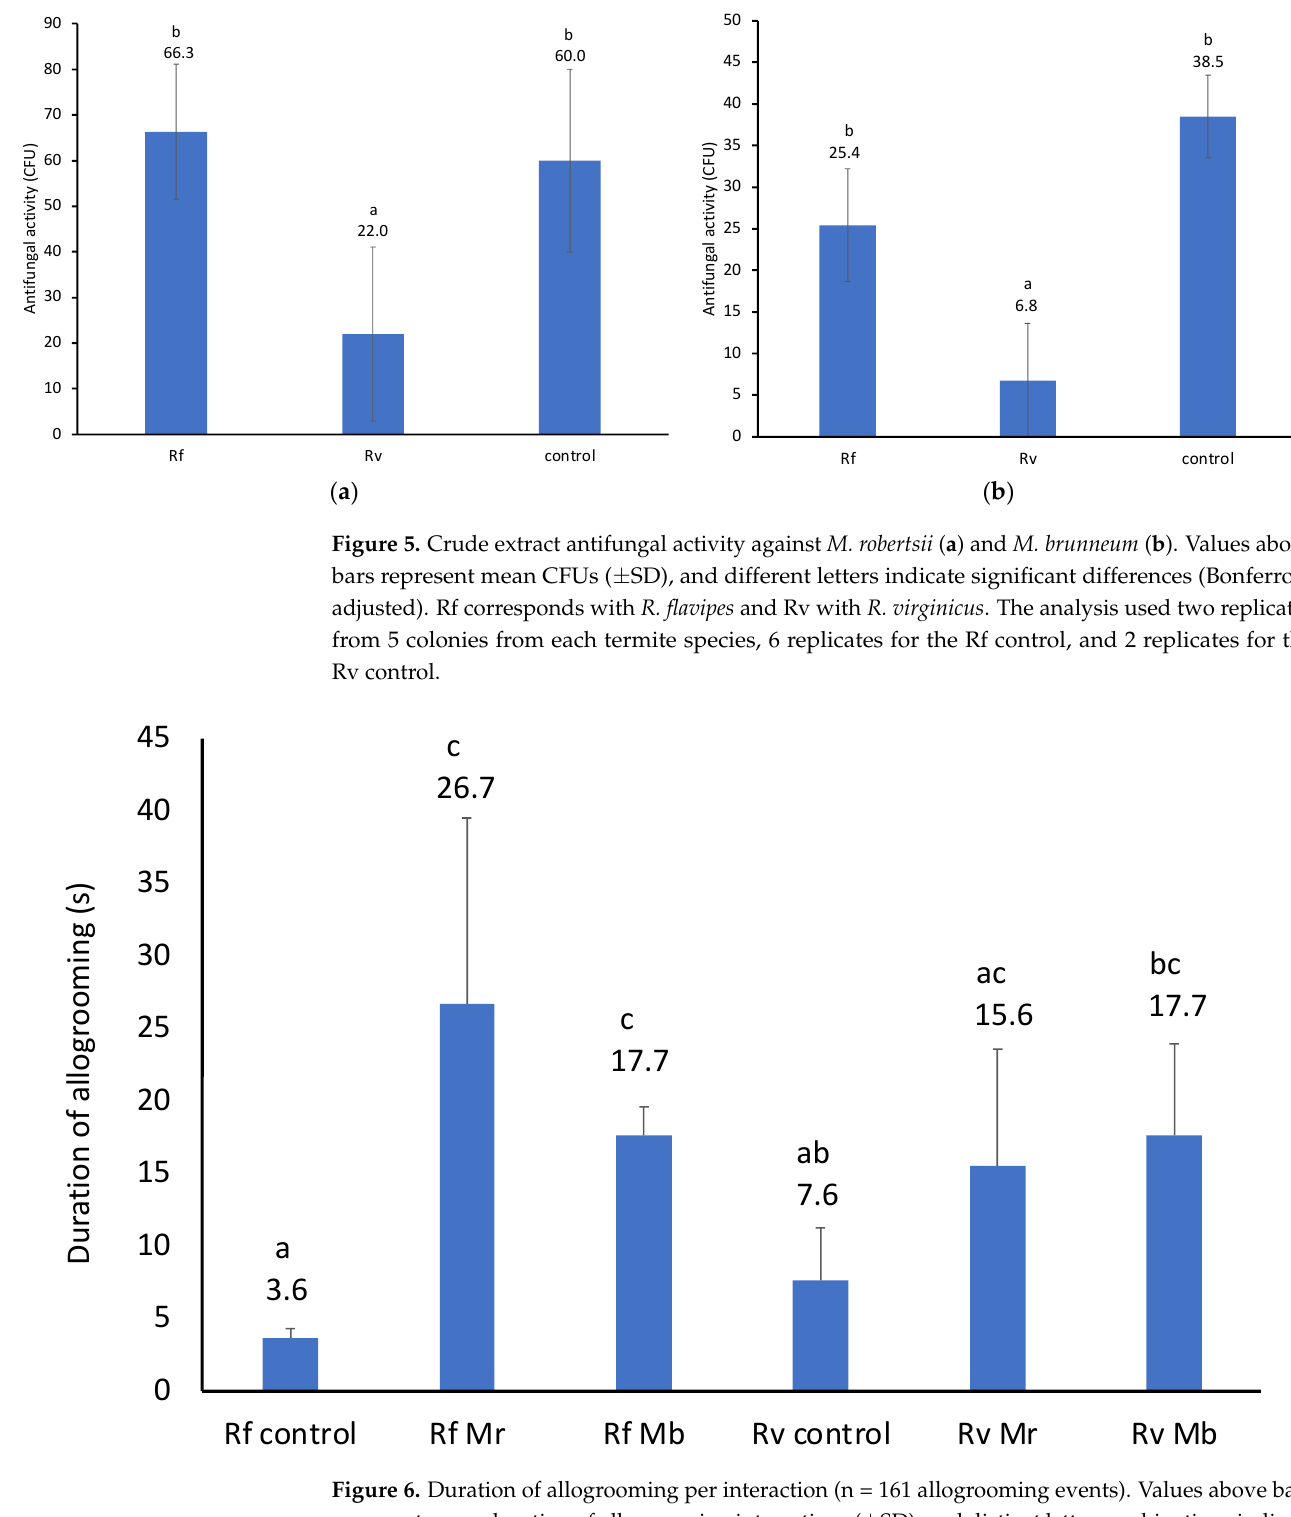
9 of 13 Figure 4. Survival of single termites after a fungal challenge (n = 96). Rf corresponds with R. flavipes , Rv with R. virginicus , Mr with M. robertsii and Mb with M. brunneum . See text for details on statistical differences between treatments. Significant survival differences for pairwise comparisons were based on Breslow tests (generalized Wilcoxon tests). * Significant difference between treatments ( p < 0.025 Bonferroni adjusted α). 3.3. Antifungal Activity of Crude Extracts The two species of fungi were analyzed separately (the viability of conidia on PDA differs between the two species). For M. robertsii , mean colony-forming units (CFUs) among fungal and control treatments were significantly different (F = 18.08, df = 2, p < 0.001) (Figure 5a). Crude extracts of R. virginicus but not R. flavipes workers showed sig- nificant antifungal activity against M. robertsii compared to the control (adjusted p < 0.001 and p = 1.000, respectively). The antifungal activity of R. virginicus extracts against M. rob- ertsii was significantly greater than the antifungal activity of R. flavipes extracts against M.